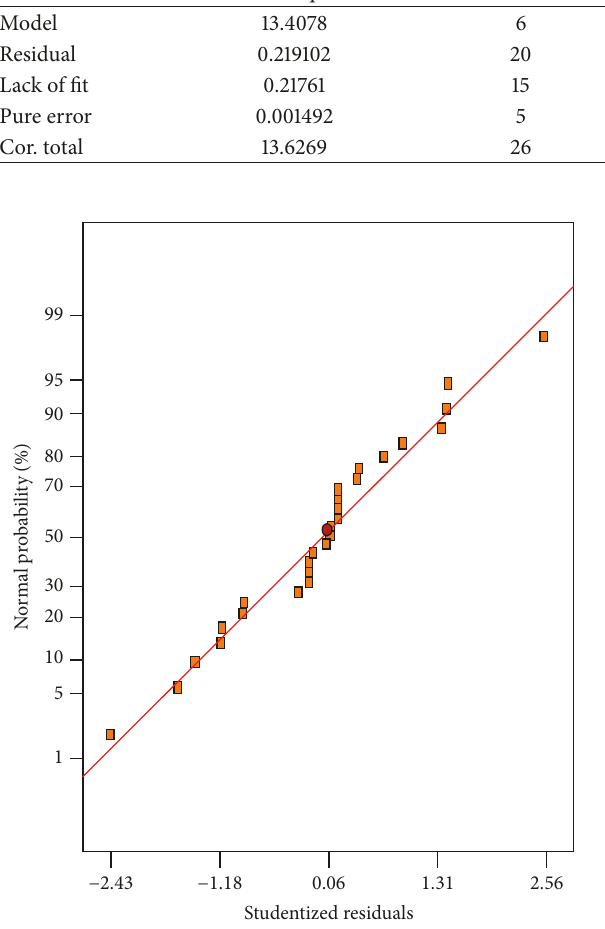
Figure 3: Normal plot of residuals.